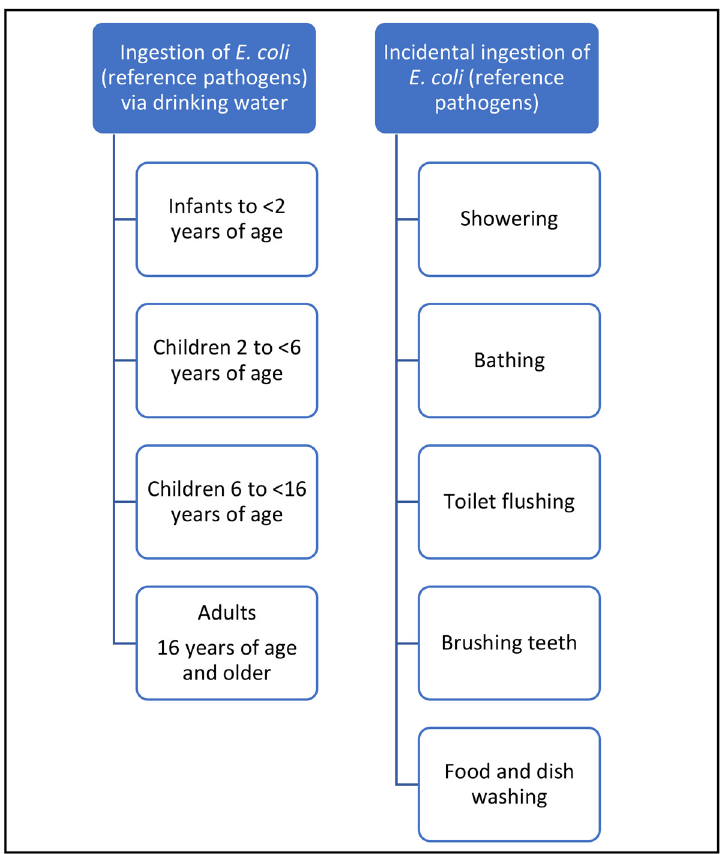
Figure 2. Exposure pathways for ingestion of well water via drinking and through incidental inges- tion.